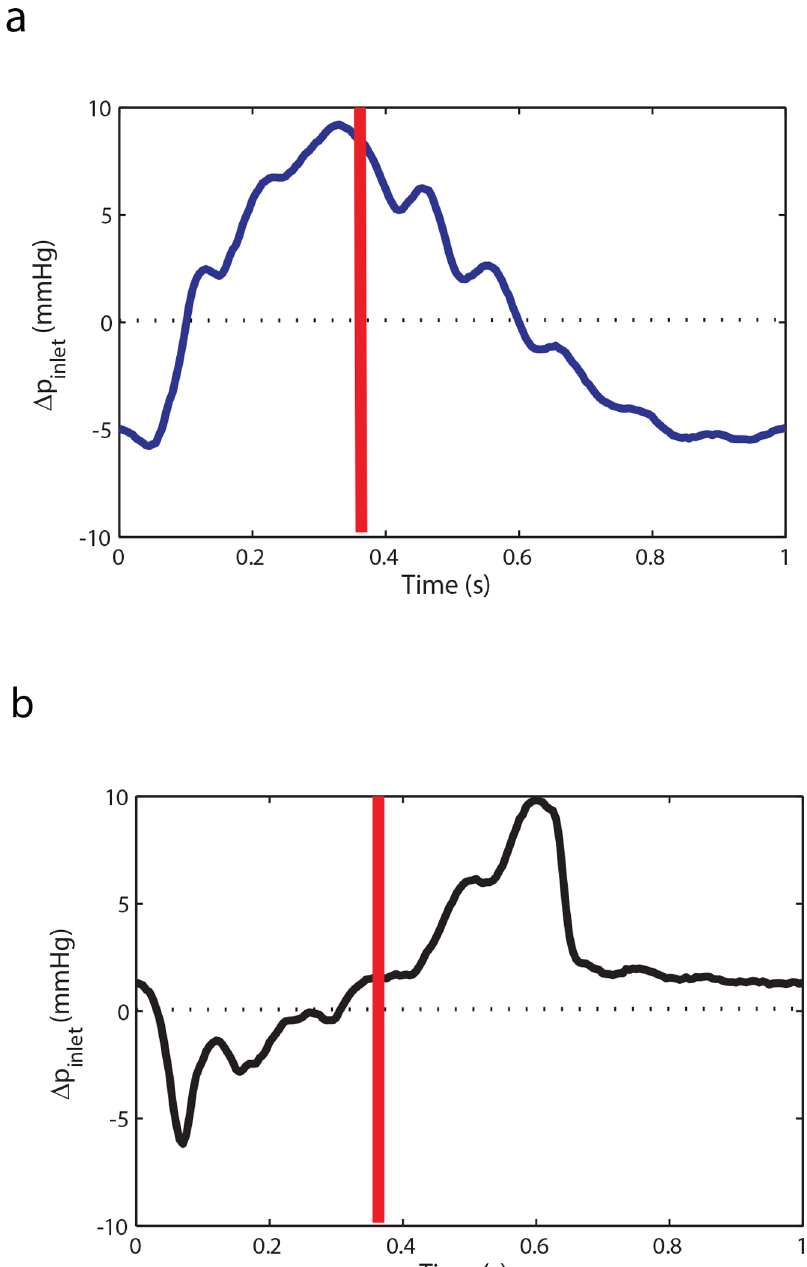
Figure 10. Pressure wave difference for ring experiment. a) The input pressure wave difference of ring 1 (destructive case) from the control ( D p ring1 =p ring1 2 p control ) at HR=60 bpm and CO=5 L/min for a complete cardiac cycle. b) The input pressure wave difference of ring 4 (constructive case) from the control ( D p ring4 =p ring4 2 p control ) at HR=60 bpm and CO=5 L/min for a complete cardiac